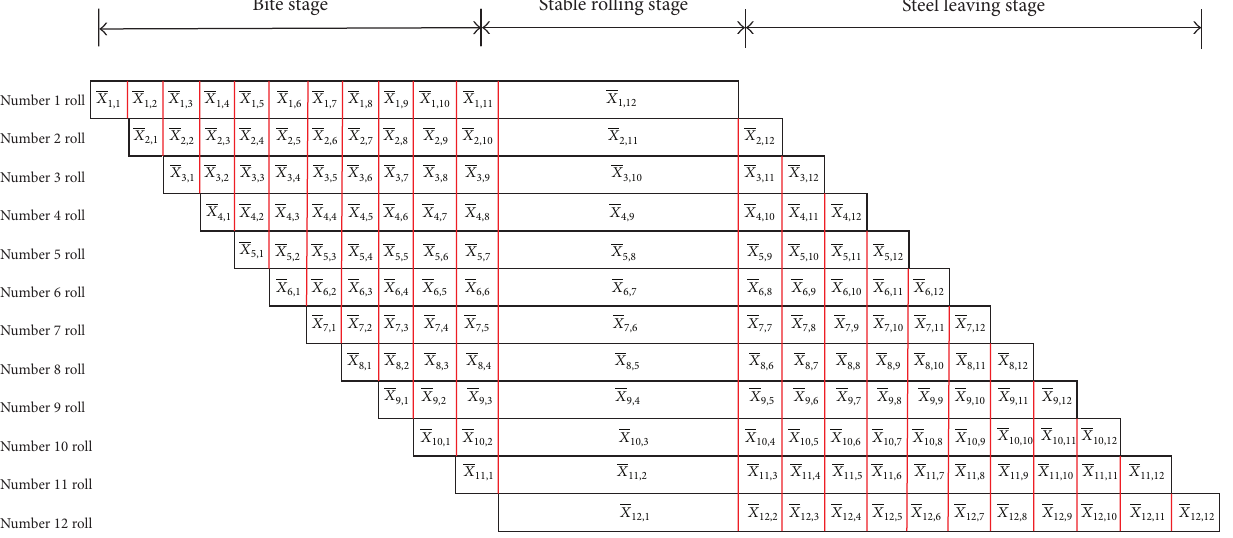
Figure 2: The relation between time and variables of reducing